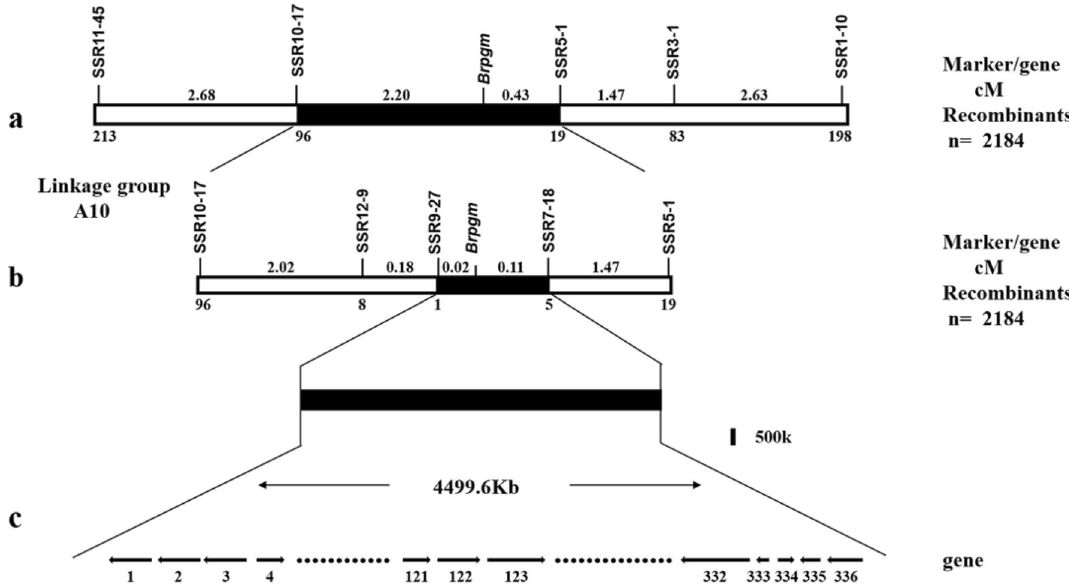
Figure 3. Genetic and physical maps of the Brpgm gene locus in Brassica rapa. ( a ) The mutant gene Brpgm was initially located between the molecular markers SSR10-17 and SSR5-1 in the A10 linkage group, with genetic distances of 2.20 and 0.43 cM, respectively. ( b ) The mutation gene Brpgm was located between SS9-27 and SSR 7–18 with genetic distances of 0.02 and 0.11 cM, respectively. ( c ) The physical size of the candidate region was 4499.6 Kb, containing 336 candidate genes.